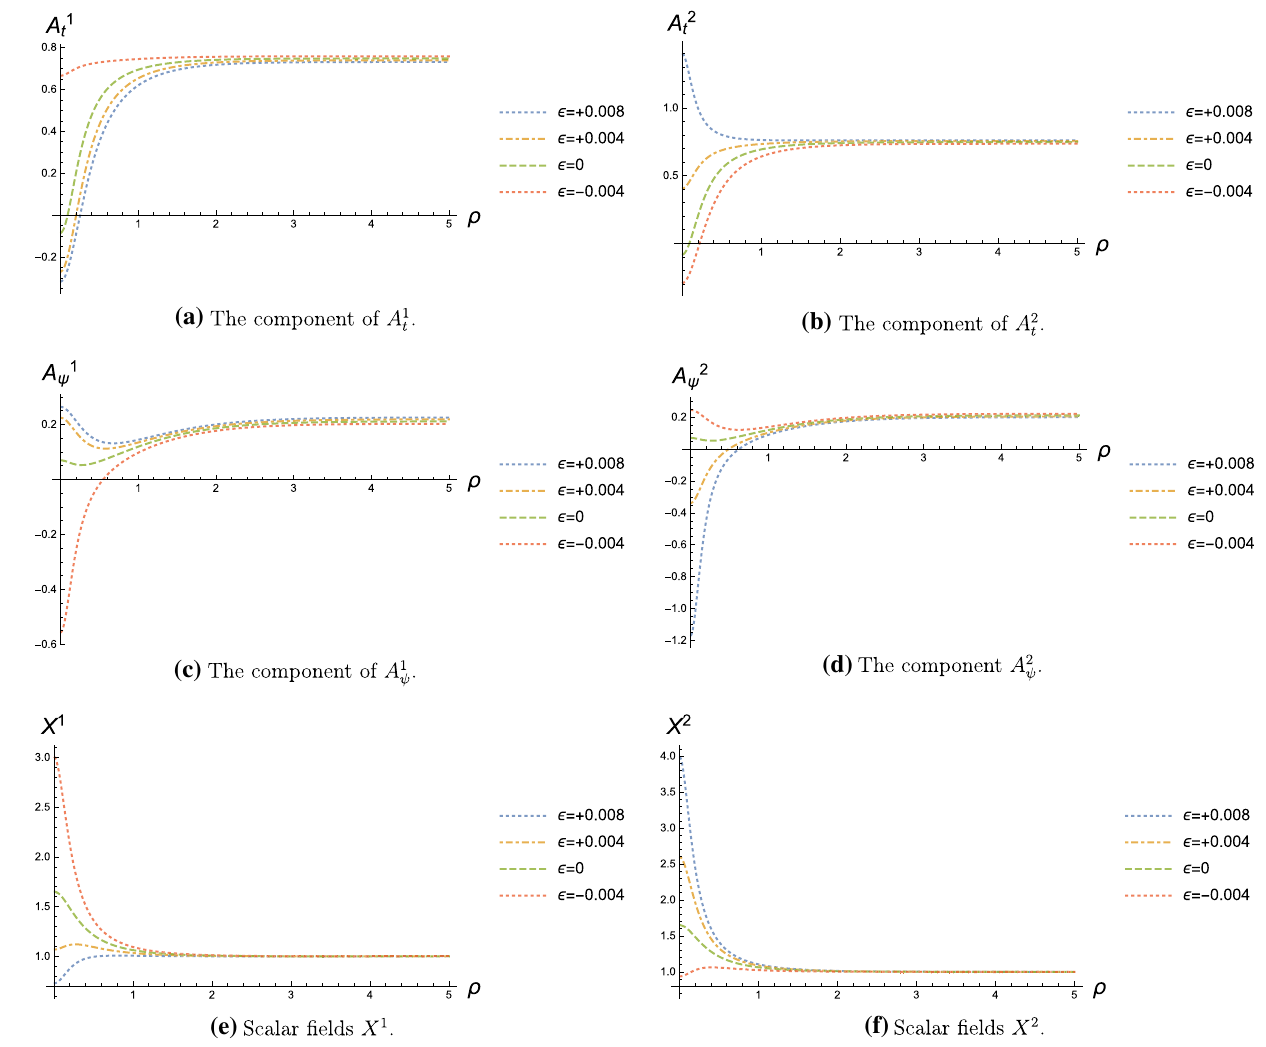
Fig. 3 Components of the gauge fields A I and scalar fields X I at α = 0 . 84, ξ = − 1 differences among the fields for the various (cid:14) are quite